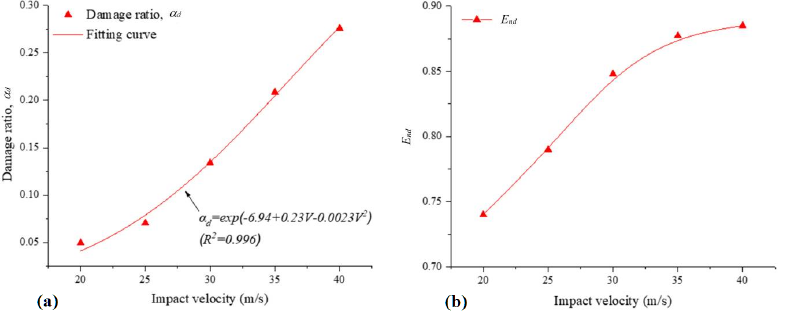
Figure 15. Dependencies of hammering parameters on impact velocity: ( a ) granite damage ratio ( α d ); ( b ) energy dissipation ( E nd ) (Zhang et al.